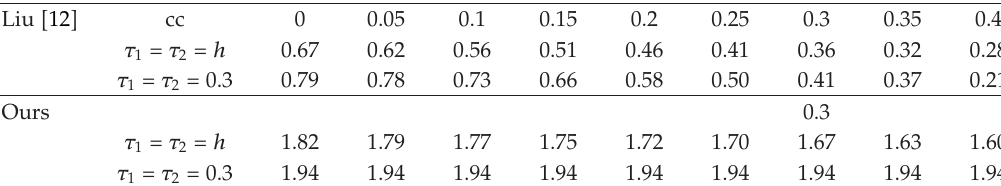
Table 4: Calculated allowable size of distributed delay h (cid:2) K (cid:9) I,E a (cid:9) E b (cid:9) E d (cid:9) 0 . 2 I (cid:3) (cid:2) Example 4.3 (cid:3) . Liu (cid:4) 12